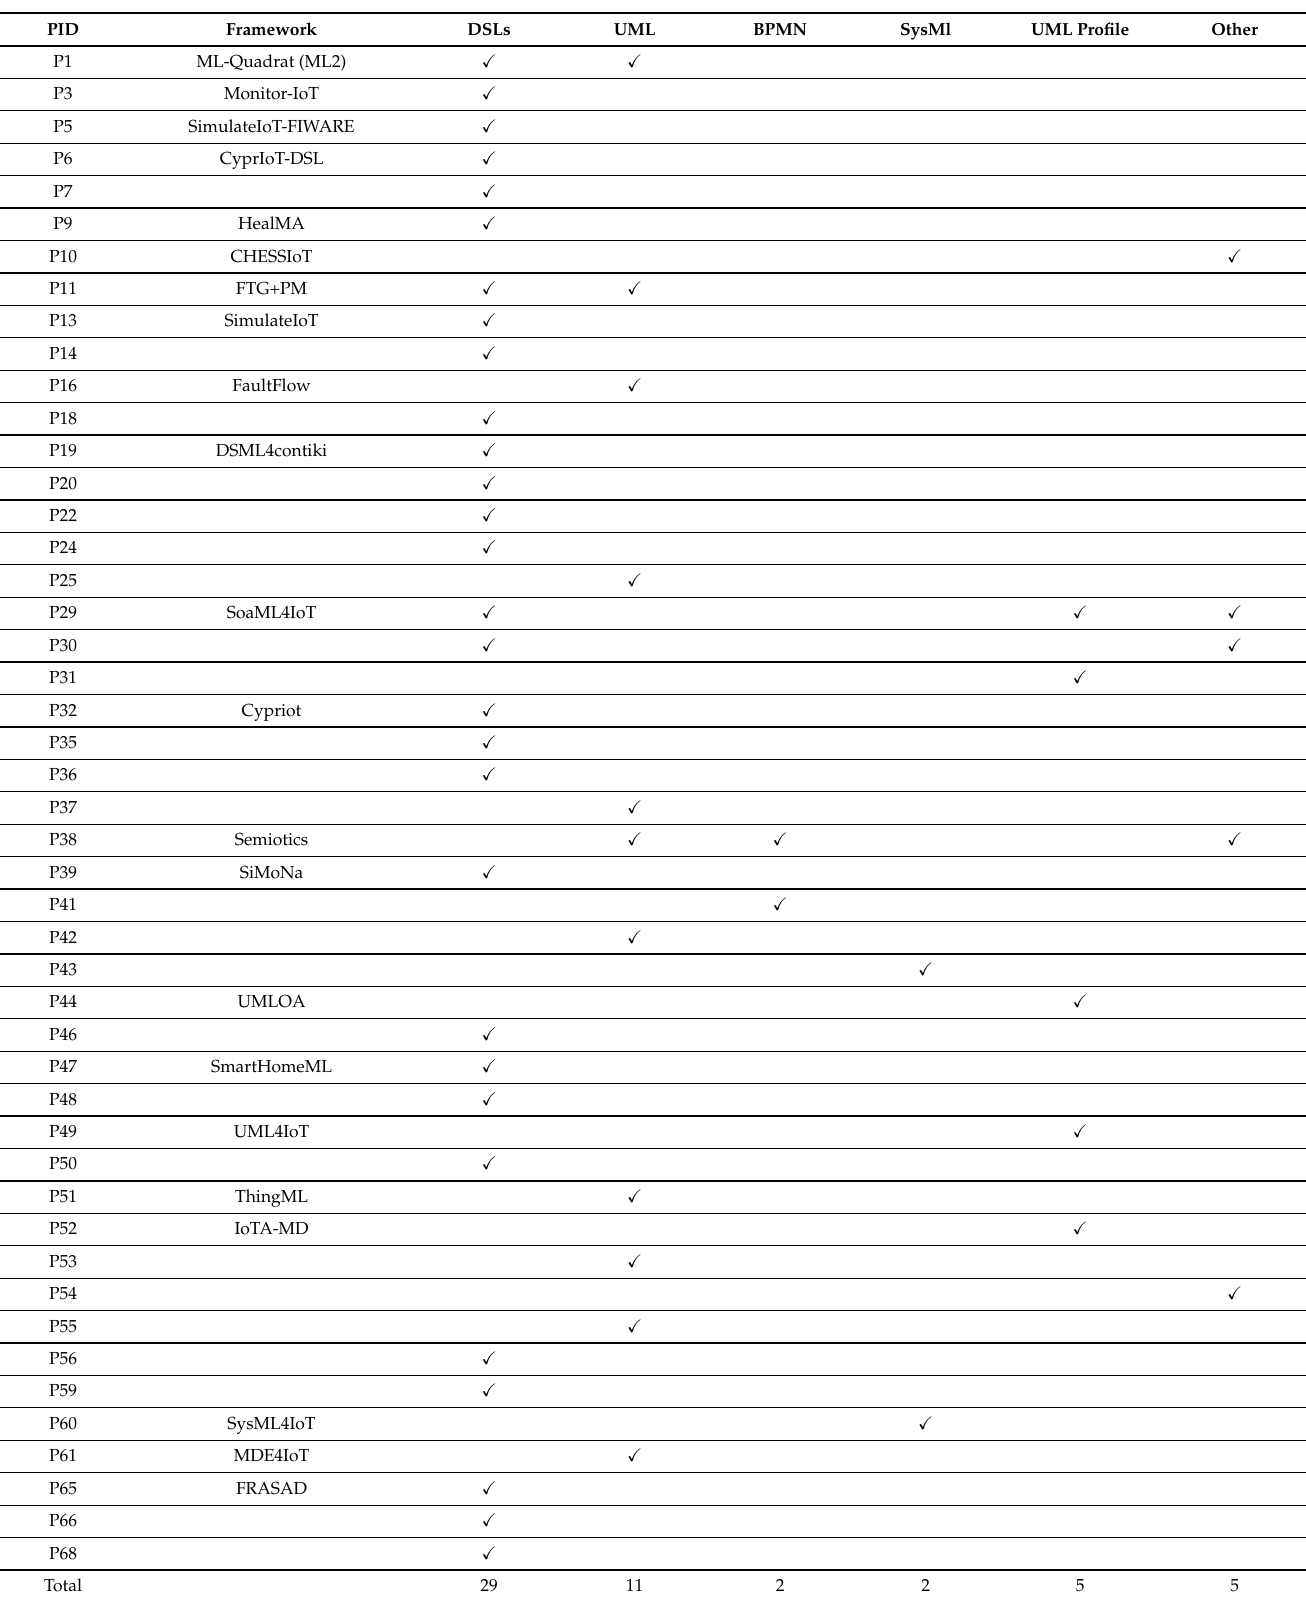
Table 2. Distribution of papers by modeling